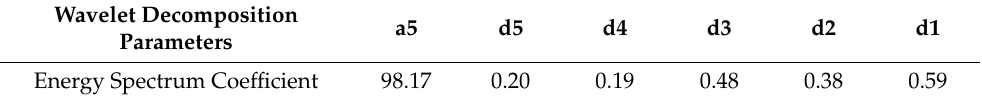
Figure 30. Waveform decomposition diagram of noise S3. The energy ratio of the decomposed layers is shown in Tables 2–4. Table 2. Energy spectrum coefficient table of noise signal S1 of Yangma Island Bridge. Wavelet Decomposition